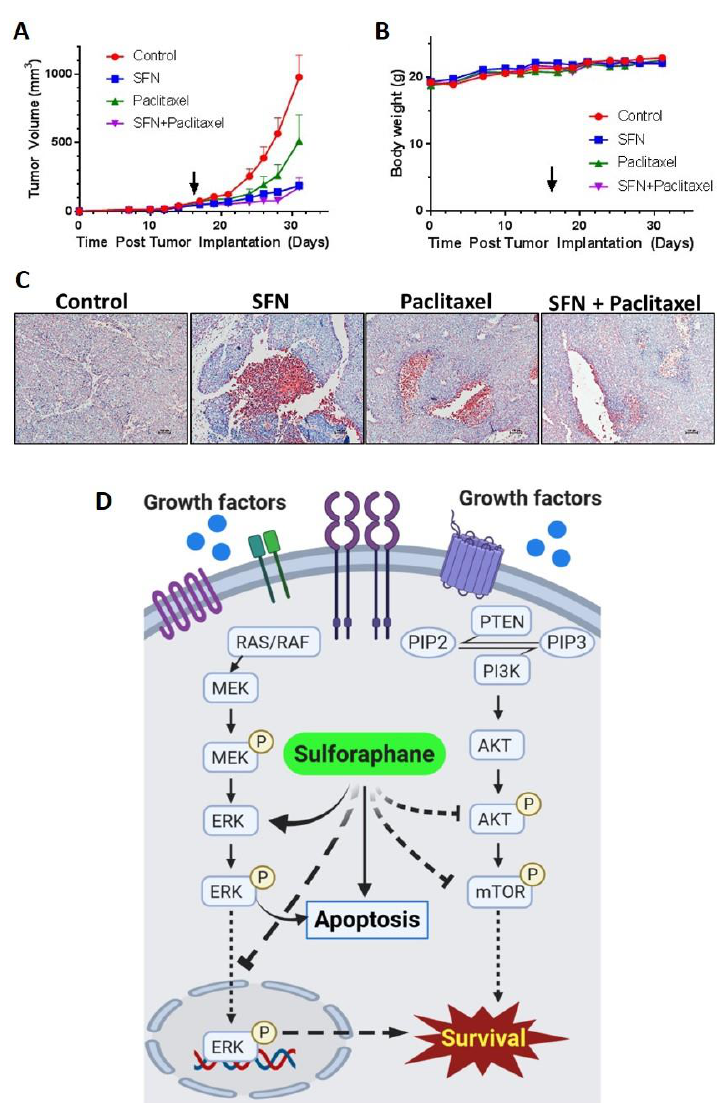
Figure 6. Sulforaphane, paclitaxel and the combination of sulforaphane and paclitaxel reduced tumor volume